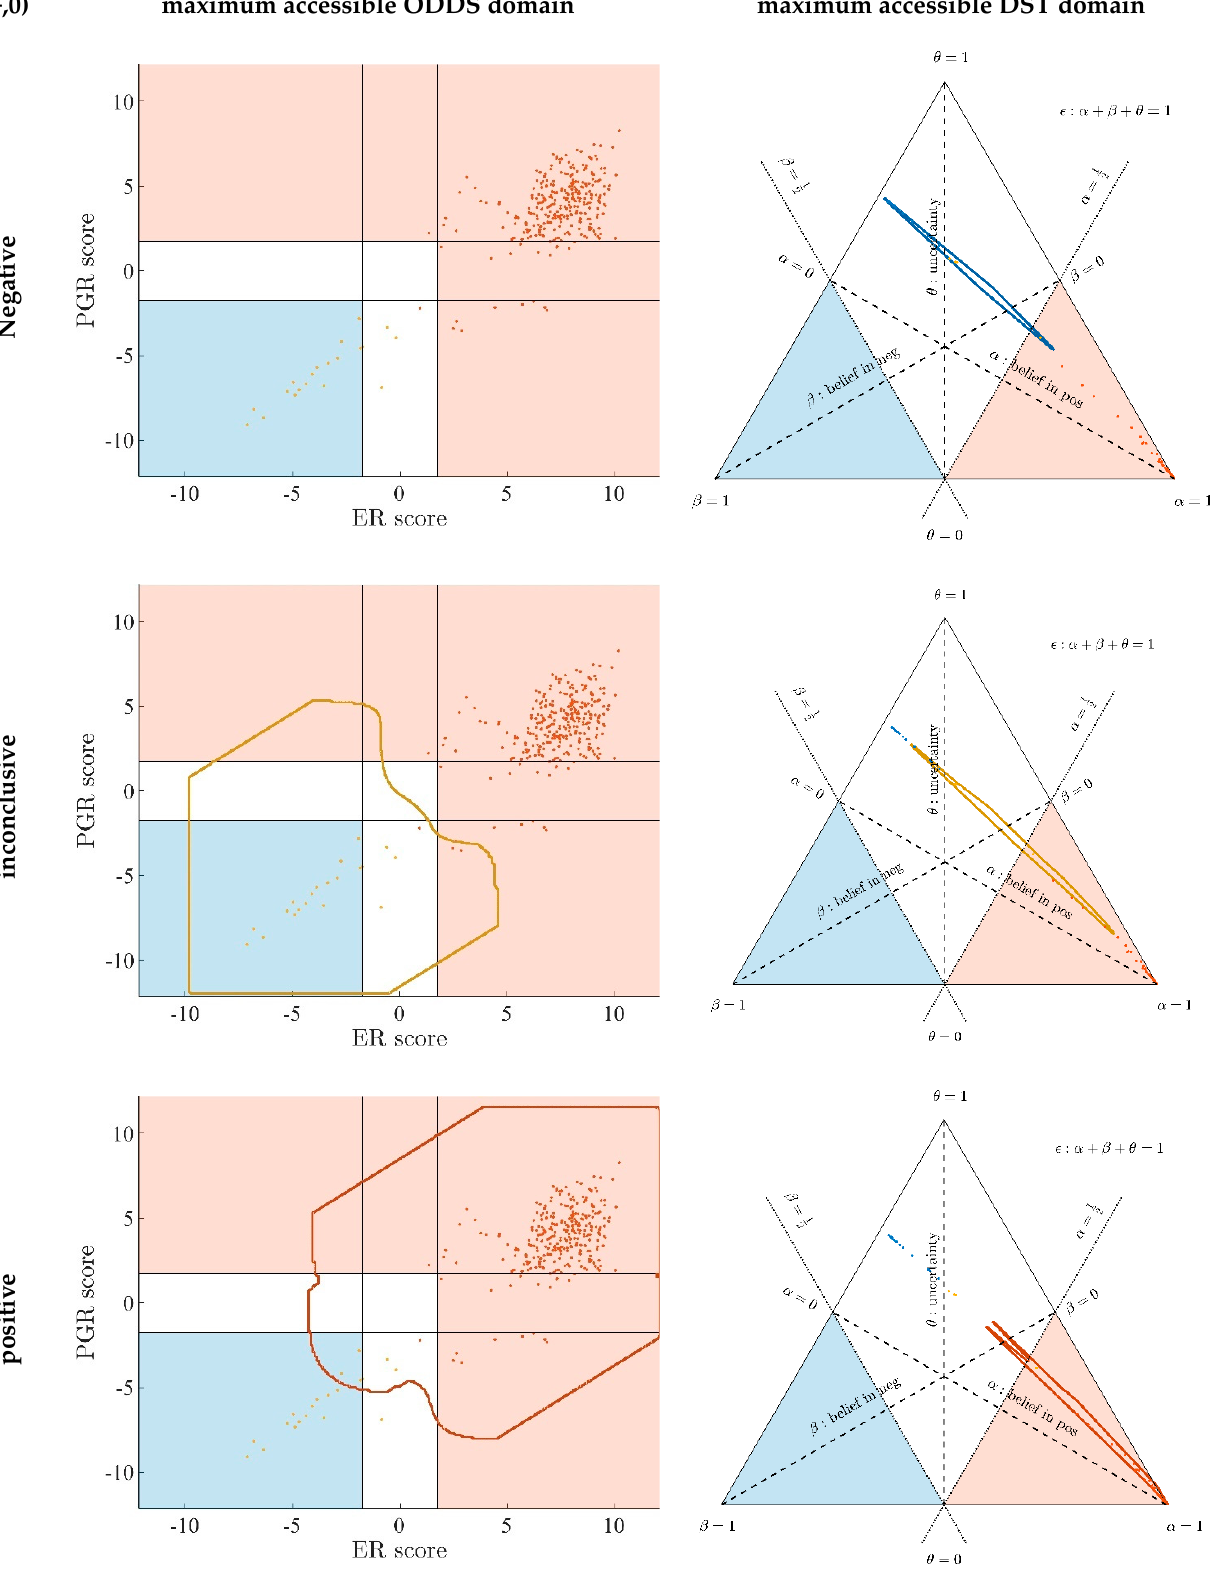
Figure A8. Real sample data within maximum accessible domains for the IHC case = (+,0). For general features of display see caption to Figure A3.